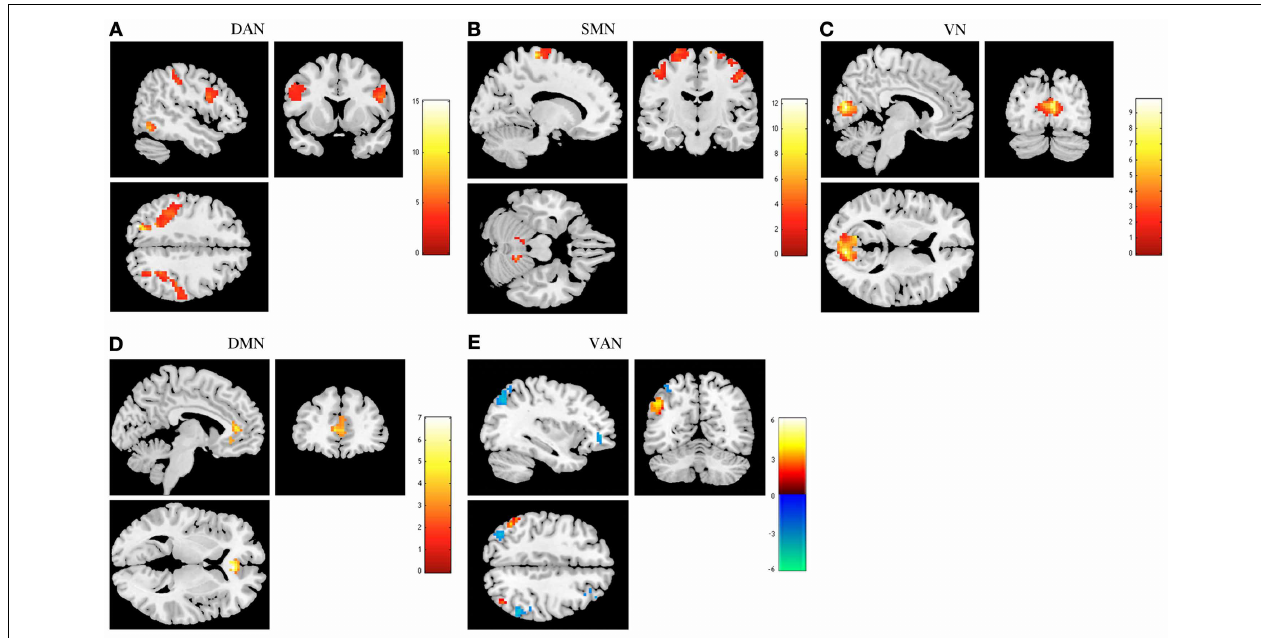
FIGURE 3 | Comparison between stress recovered participants and controls in resting state networks (RSNs). The images show areas in which stress recovered participants display greater functional connectivity than controls in the dorsal attention network (DAN) (A) , sensorimotor network (SMN) (B) , and primary visual network (VN) (C) . Lower functional connectivity was found in the default mode